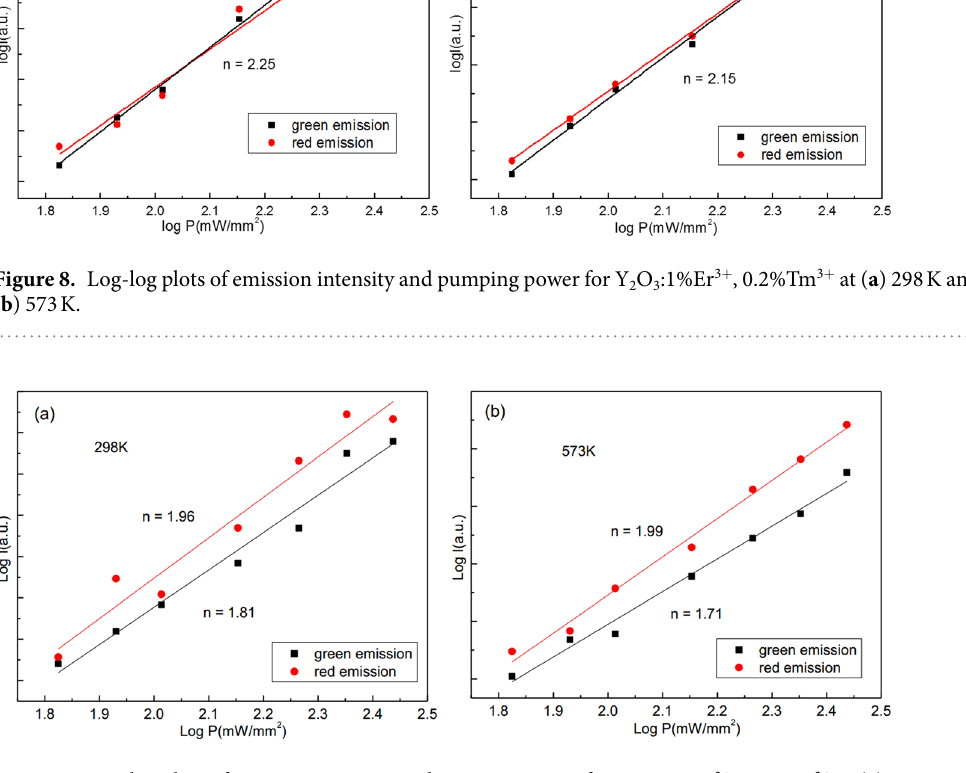
Figure 9. Log-log plots of emission intensity and pumping power for Y 2 O 3 :1%Er 3 + , 0.5%Ho 3 + at ( a ) 298 K and ( b ) 573